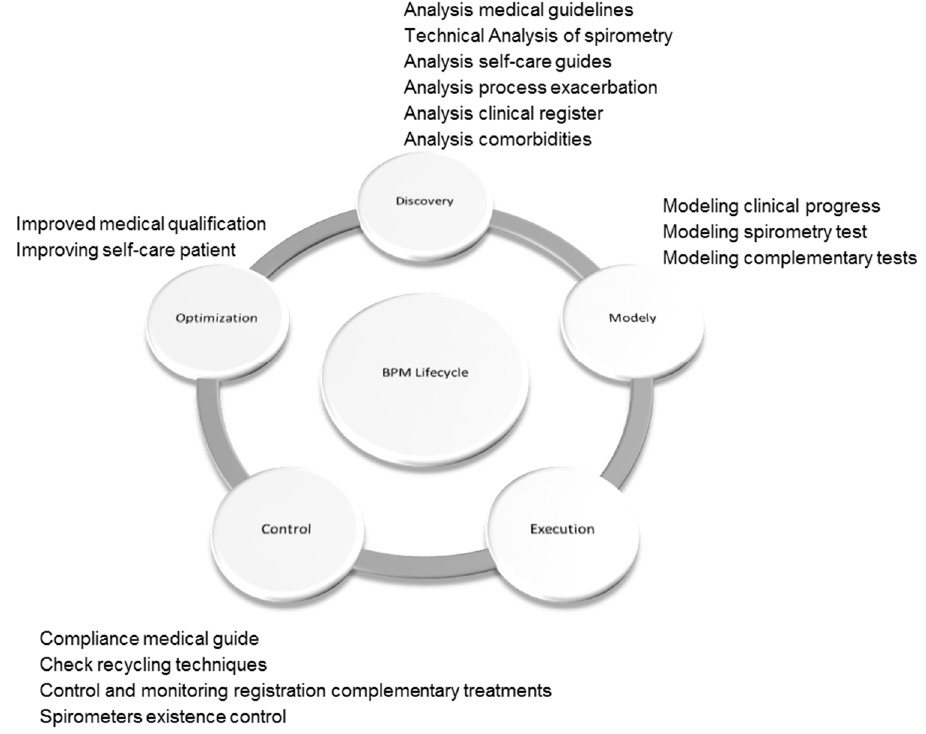
Figure 1. BPM life cycle applied to COPD clinical